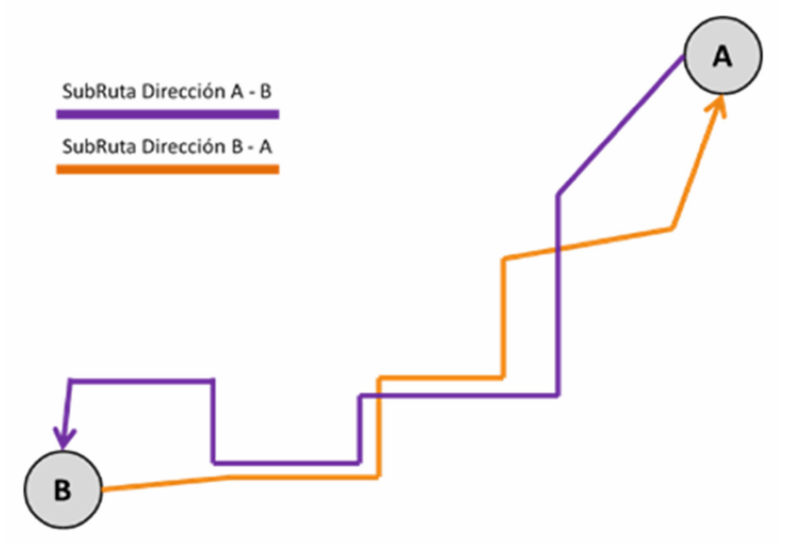
Figure 2. An example of an asymmetrical bus